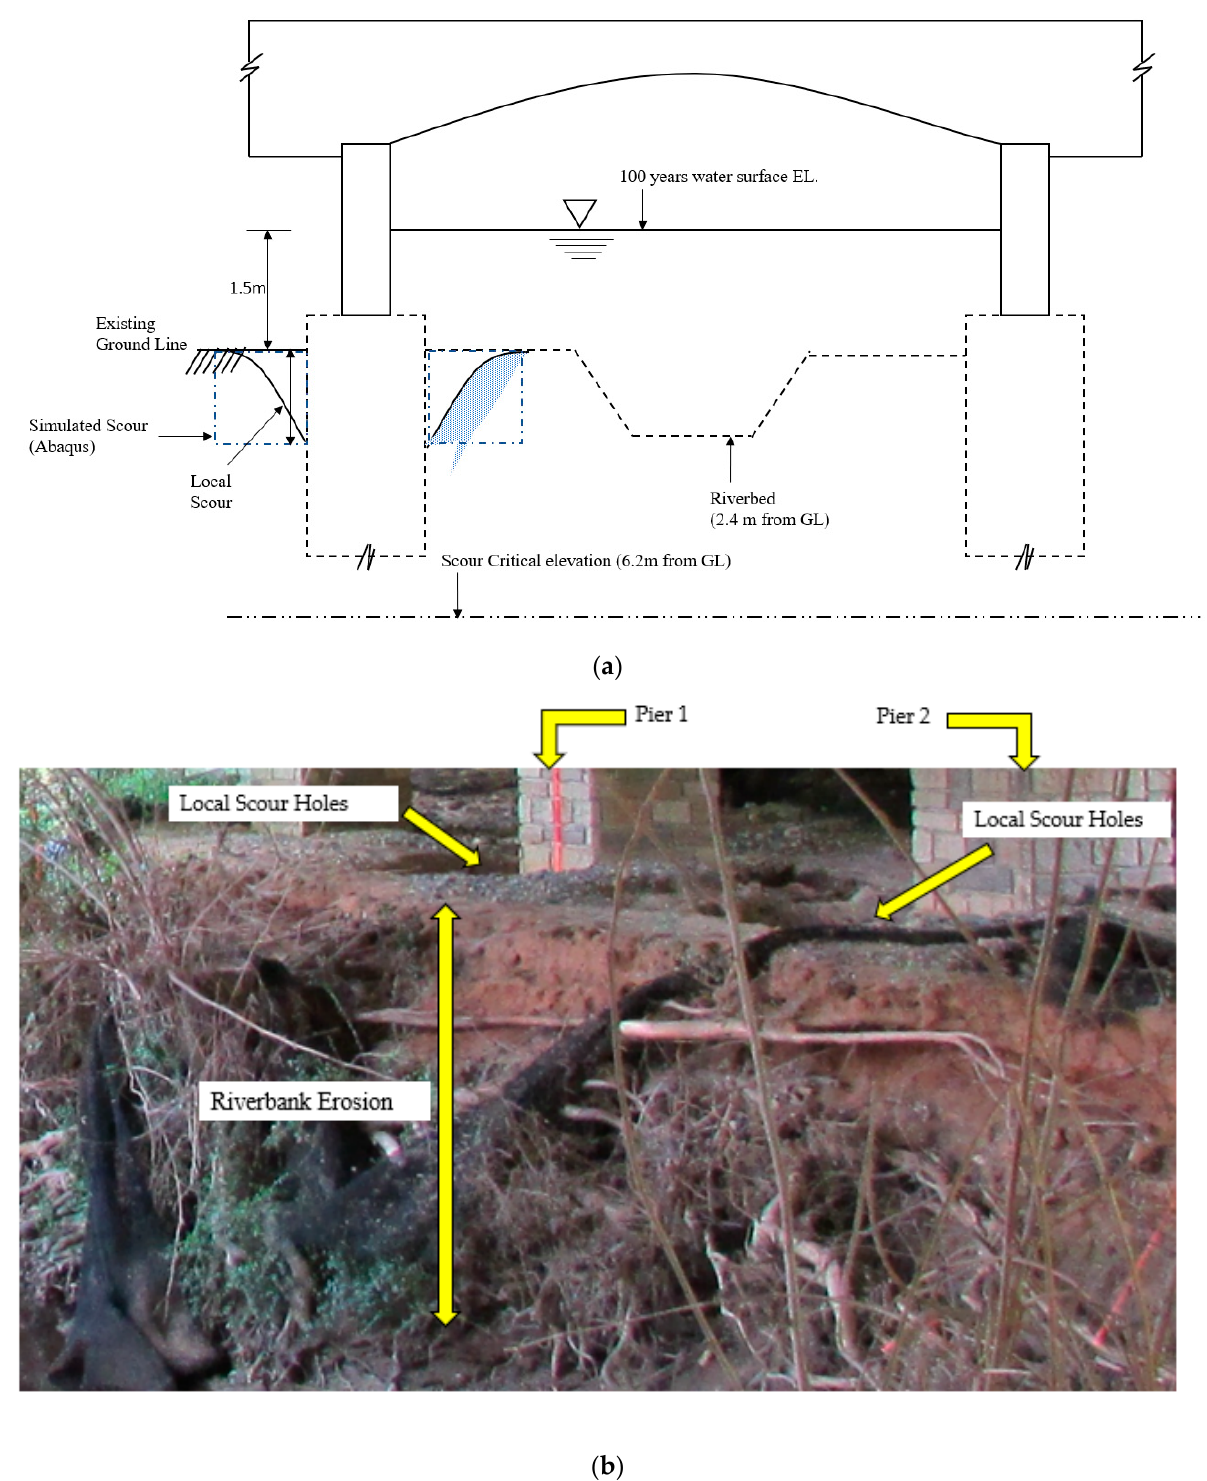
Figure 4. Phillips Road bridge scour development: ( a ) Schematics of the local scour formation and simulation (view to north with west end of bridge on the left) and ( b ) local scouring around bridge pier and channel erosion after a torrential rain on west bank of Toby Creek (view to southwest) (photo credit: S.E. Chen).